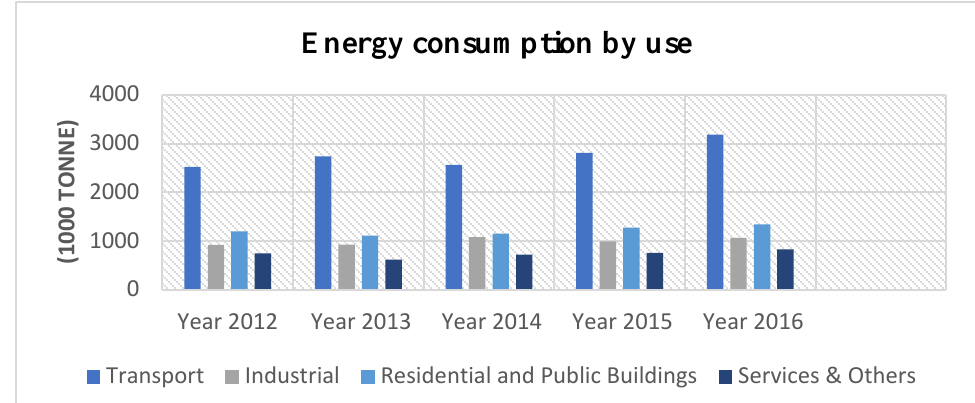
Figure 1. Final energy consumption by sector between 2012 and 2016 in Jordan.